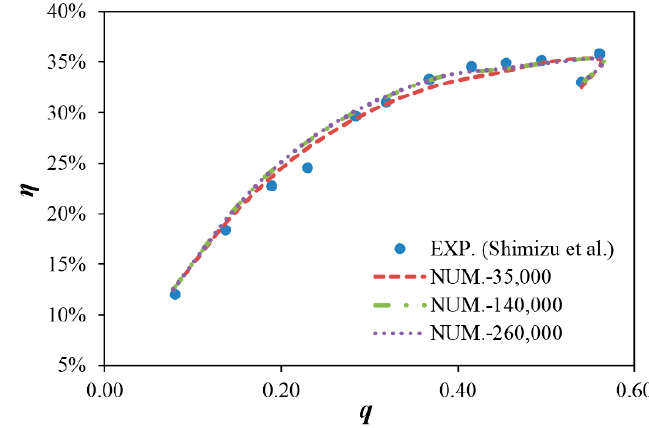
Figure 5. Comparison of the experimental and numerical results.